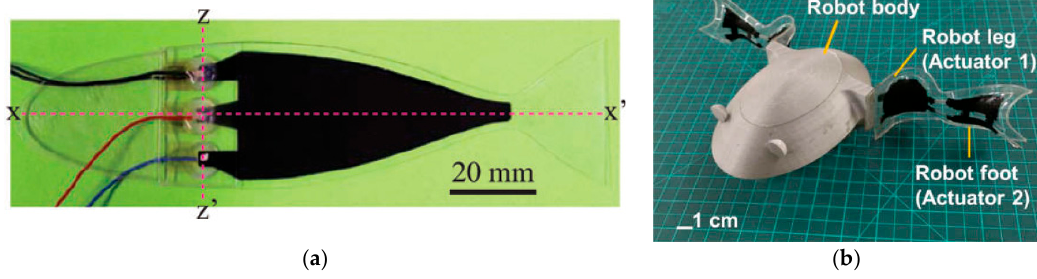
Figure 11. DEA driven swimming robot: ( a ) Fish robot [115]; ( b ) Frog robot [117].